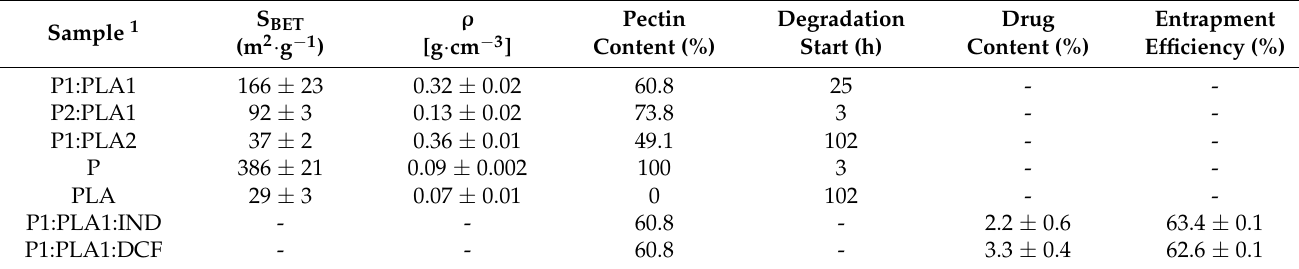
Table 2. Sample characterization.